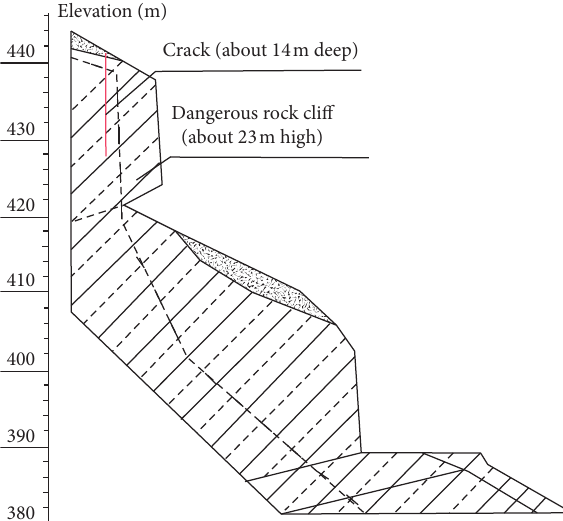
Figure 11: Tipping-type dangerous rock mass of W